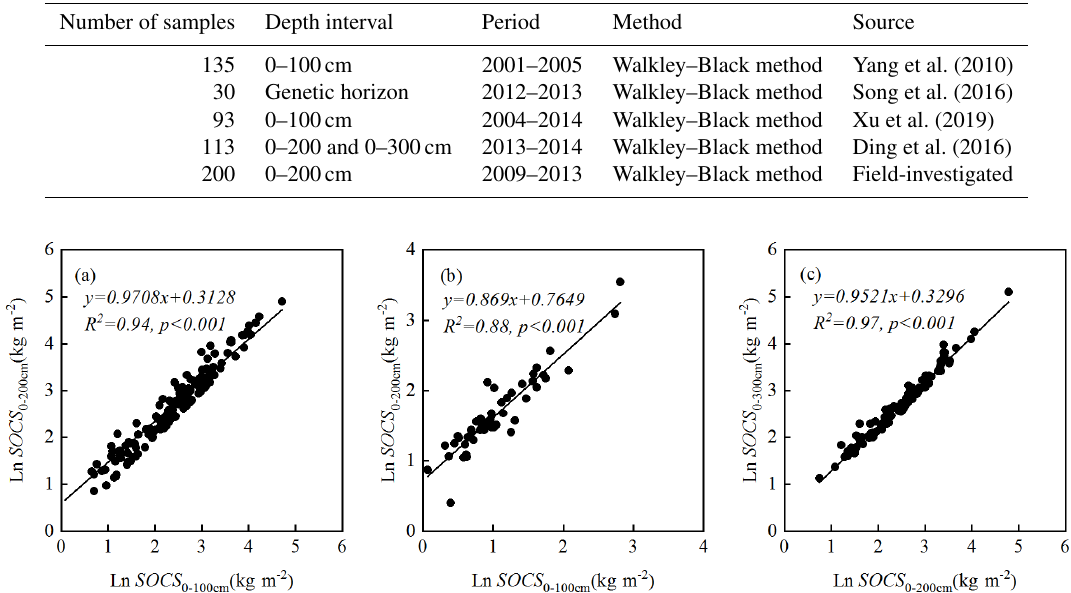
Table 1. Summary of soil organic carbon datasets used in this study.